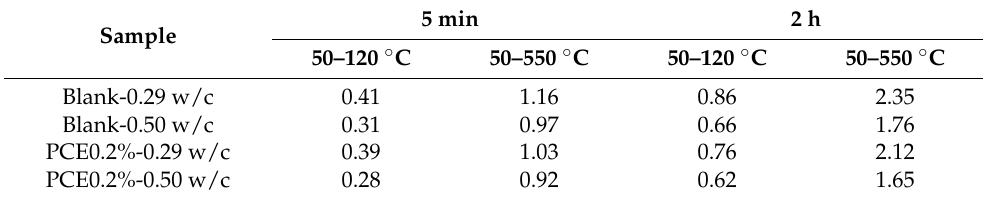
Table 5. Weight loss (%) of the pastes in the range 50–120 °C and 50–550 °C.